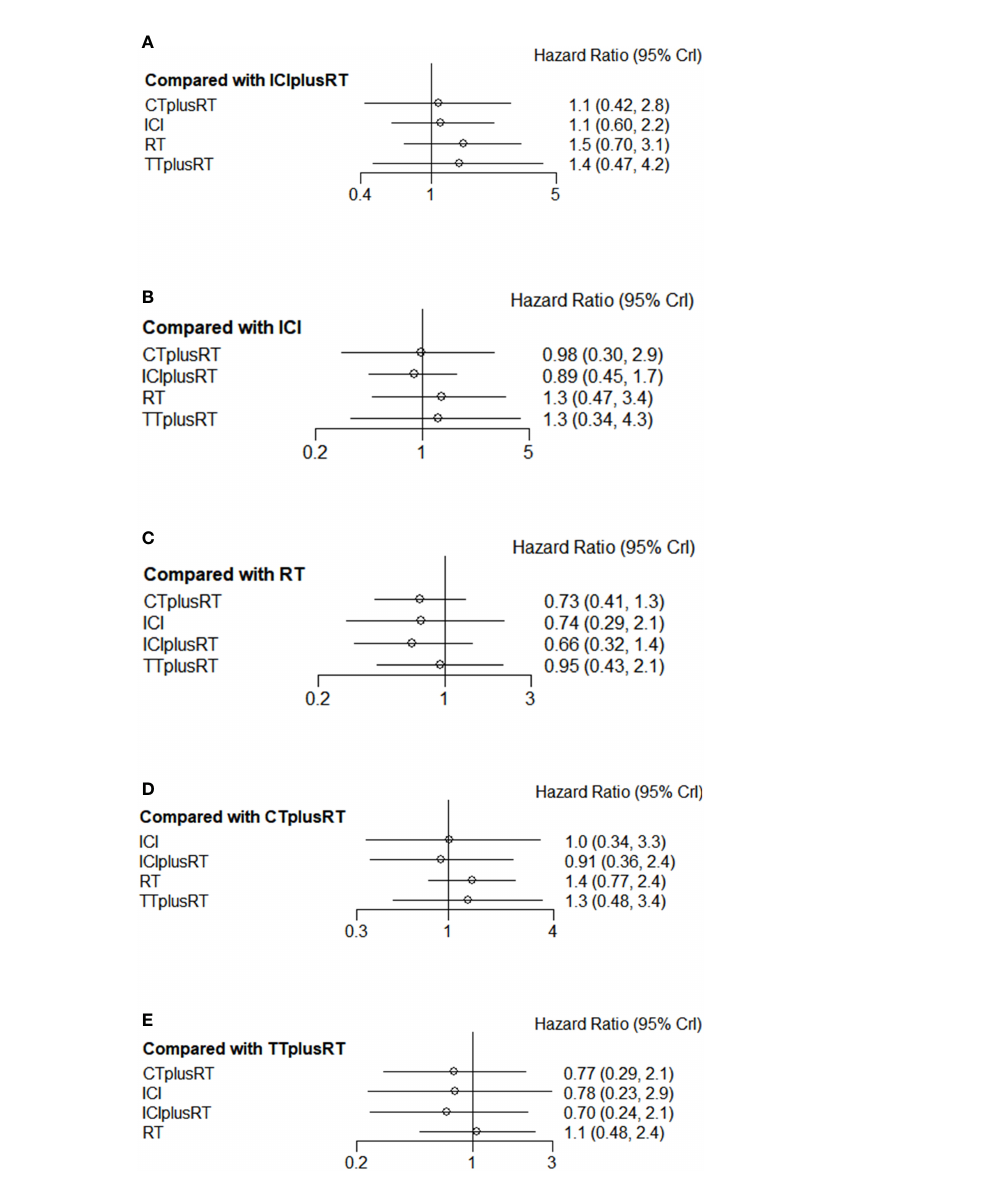
FIGURE 6 Forest plots of multivariable interventions for PFS. (A) Compared with Immune checkpoint inhibitor combined with radiotherapy (ICIplusRT); (B) Compared with Immune checkpoint inhibitor (ICI); (C) Compared with radiotherapy (RT); (D) Compared with chemotherapy combined with radiotherapy(CTplusRT); (E) Compared with targeted therapy combined with radiotherapy